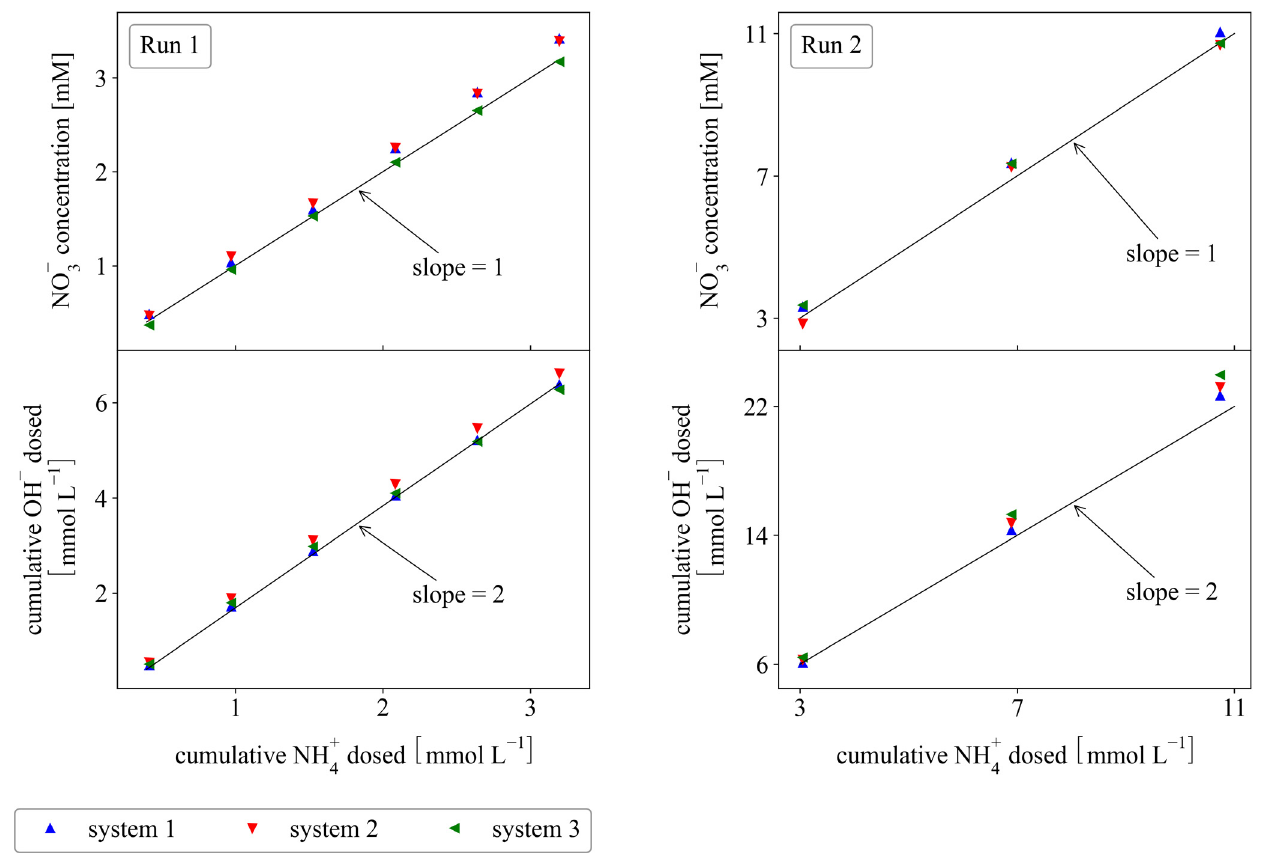
Figure 1. Results from runs 1 and 2 in which ammonium was dosed in a fed-batch system at 0.56 and 3.92 mmol-N L –1 day –1 , respectively. The pH was controlled at 6.5 via feedback-PI-control (independent of ammonium dosing). Shown are the measured nitrate concentrations in solution, and the cumulative amounts of hydroxide dosed to control the pH.